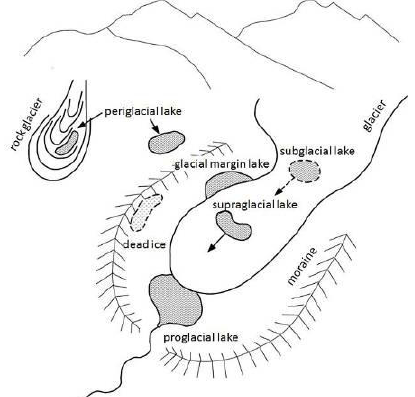
Figure 1. Water bodies next to a glacier (after Raymond et